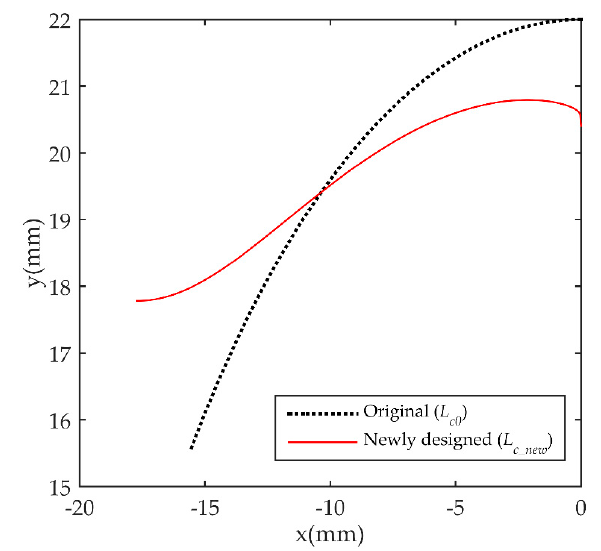
Figure 8. The newly designed cam profile L c_new and the original cam profile L c0 on x - y coordinates.